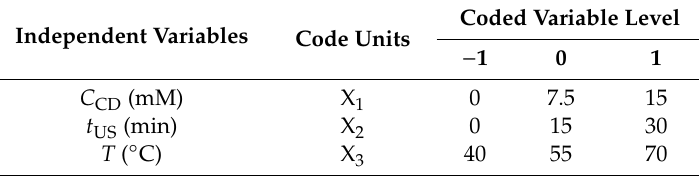
Table 1. Process variable levels and corresponding